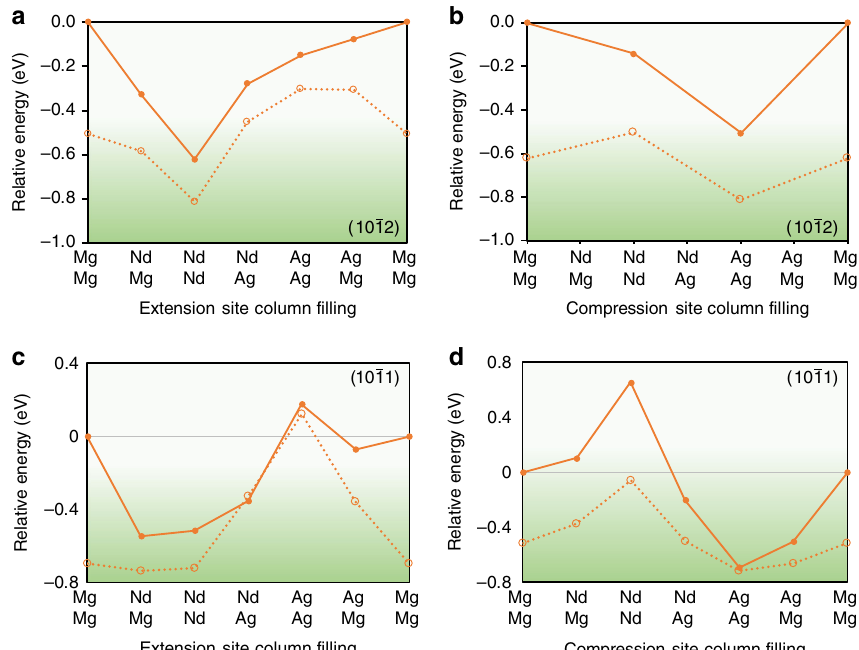
Fig. 3 First-principles calculated energies for solutes at twin boundaries. a Relative energies of fi lling the extension site column in the 10 (cid:1) 12 ð Þ twin interface, b the compression site column in the 10 (cid:1) 12 ð Þ twin interface, c the extension site column in the 10 (cid:1) 11 ð Þ twin interface, and d the compression site column in the 10 (cid:1) 11 ð Þ twin interface. In ( a , c ) solid lines represent energies when the compression site is fi lled with Mg, while the dashed line gives energies where the compression site is fi lled with Ag. The solid line in ( b , d ) is for calculations with Mg fi lling the extension site and the dashed line has Nd fi lling the extension site. All energies are relative to complete fi lling by Mg in both the extension and compression